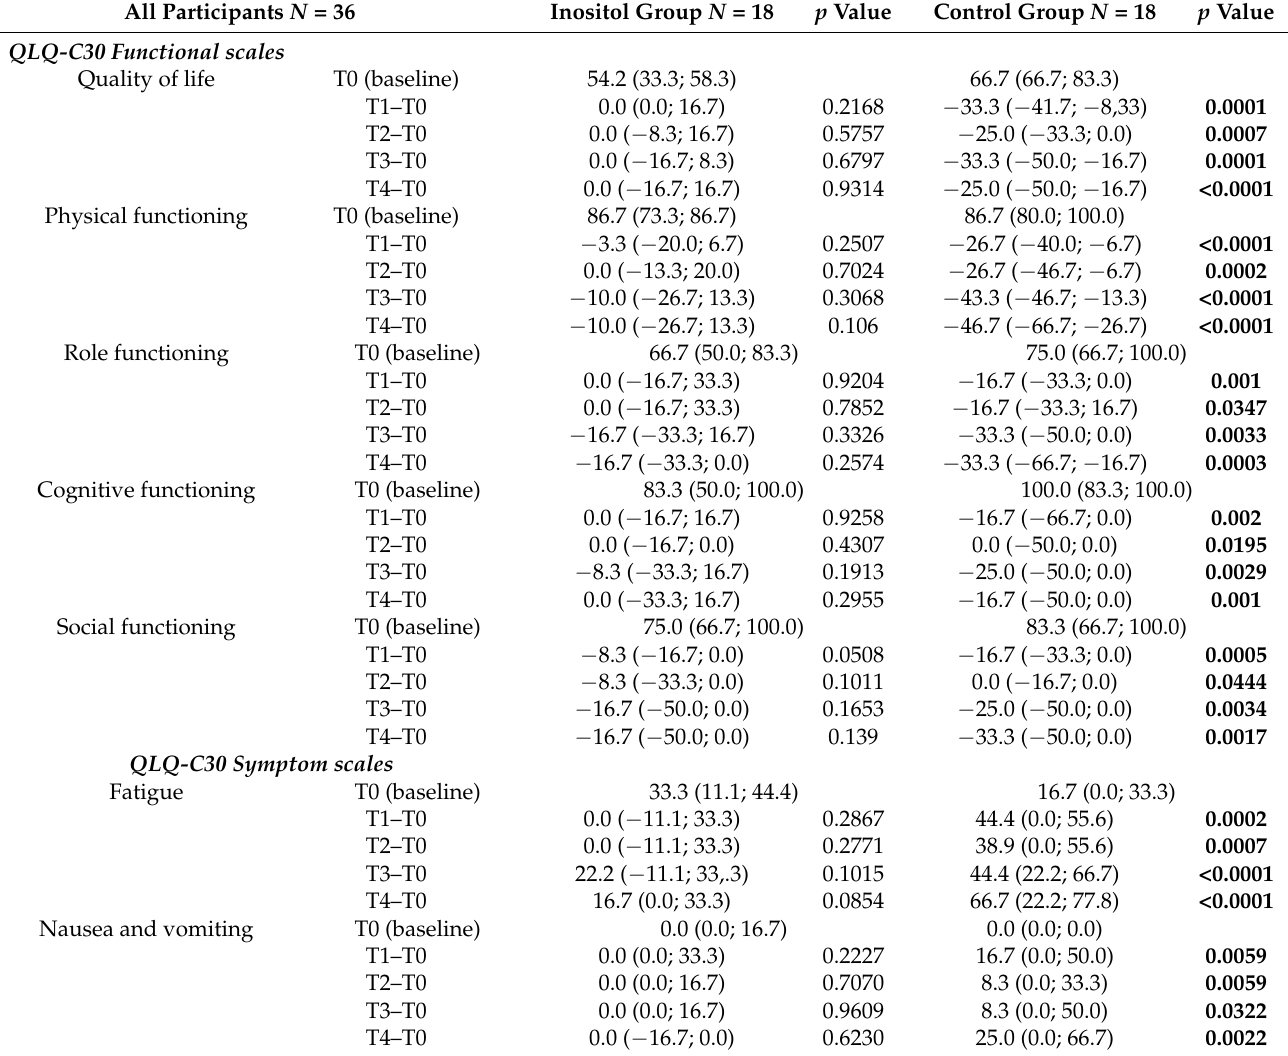
Table 3. Variations of QLQ-C30 questionnaires’ scores from baseline (T0) to T1-T4 in the Inositol Group and in the Control